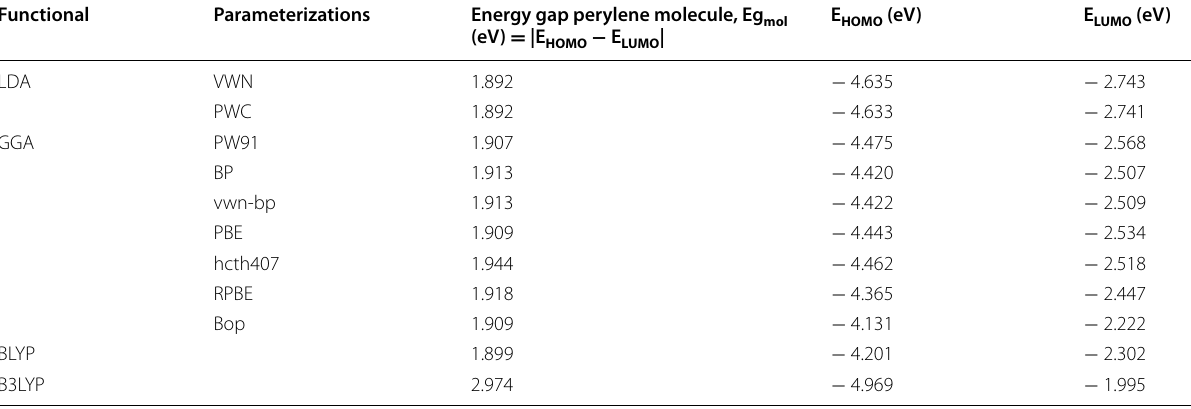
Table 2 The energy gaps of isolated perylene molecule using various E